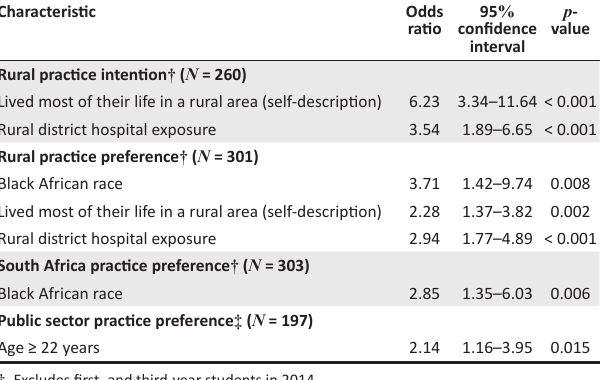
TABLE 5: Factors associated with practice intention and preferences.